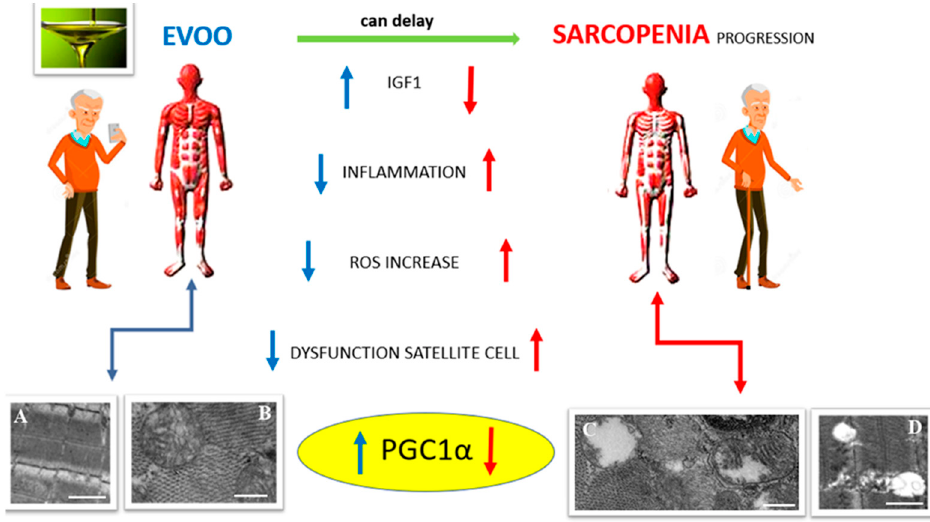
Figure 4. EVOO exerts a protective effect against sarcopenia. EVOO can upregulate IGF-1 expression, reduce inflammation and ROS, maintain satellite cell function and, in particular, acts by modulating PGC1- α expression, thus guaranteeing mitochondrial biogenesis and homeostasis. Electron micrographs of longitudinal ( A , D ) and transverse ( B , C ) sections of mouse skeletal muscle tissue show a preserved myofiber organization ( A ) and heathy mitochondria ( B ), or evident damage, with empty mitochondria ( C ), altered mitochondrial cristae ( C ) and degenerated sarcomere organization ( D ) following atrophic conditions. Bars: 1 µm for A and D; 250 nm for B and C.